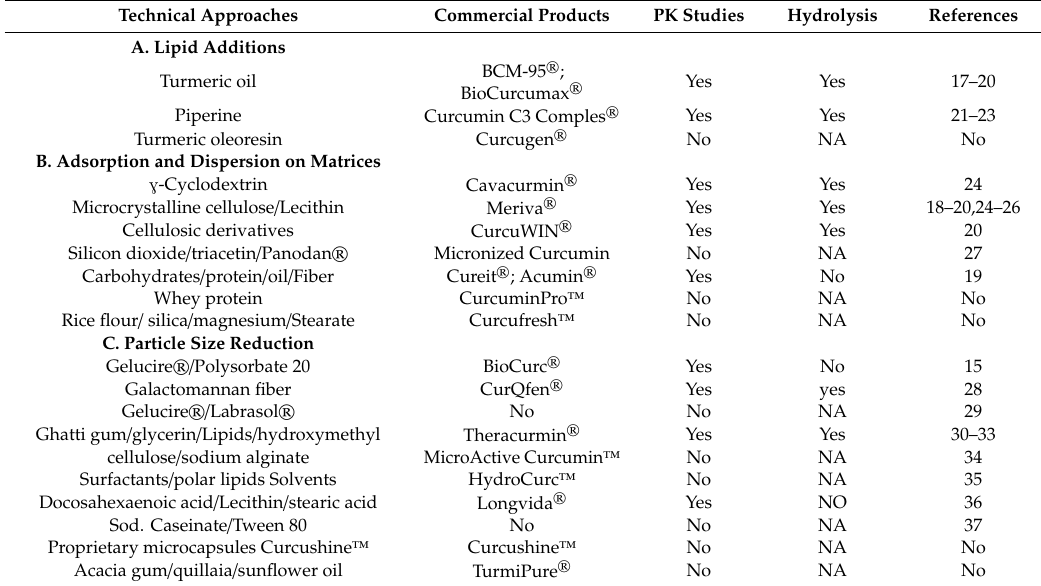
Table 1. Curcumin Formulation Strategies to Enhance